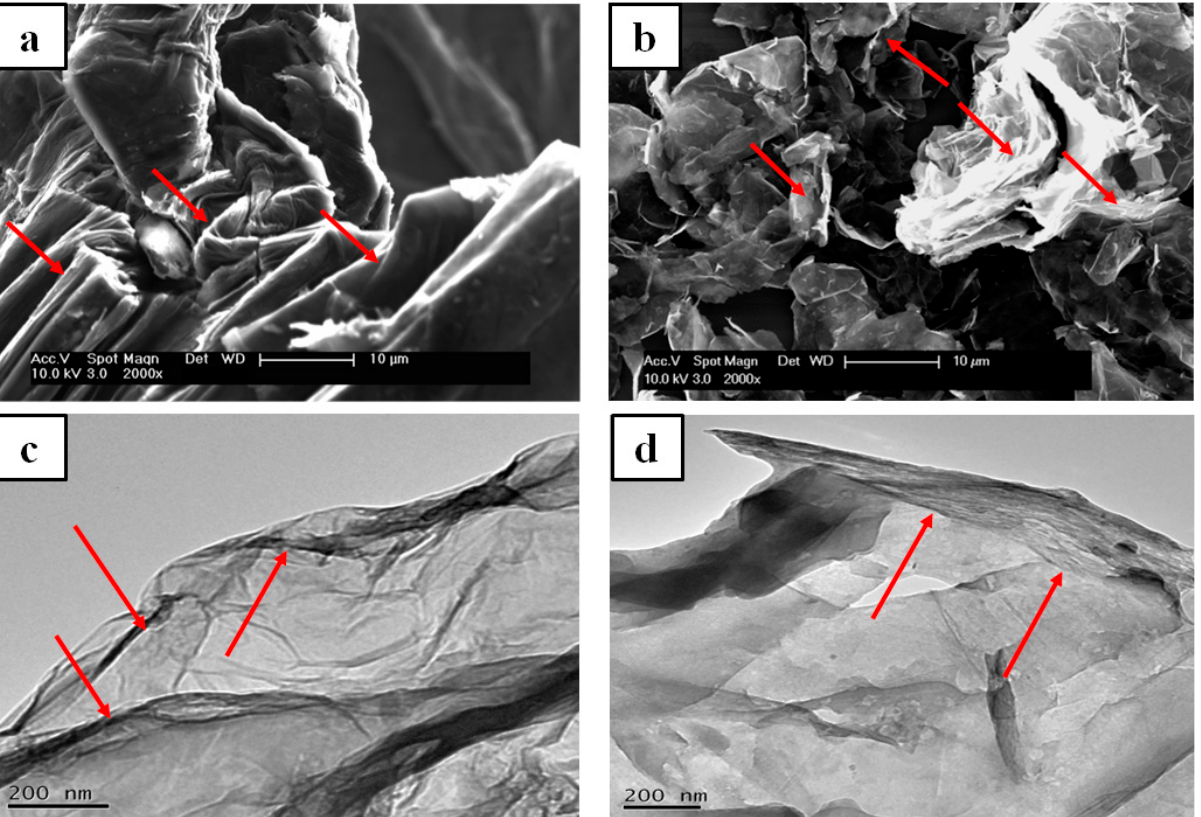
Figure 3. SEM and TEM images: ( a , c )—GO; ( b , d )—GNP. The red arrows indicate the folding and wrinkling areas and aggregation regions of GO.